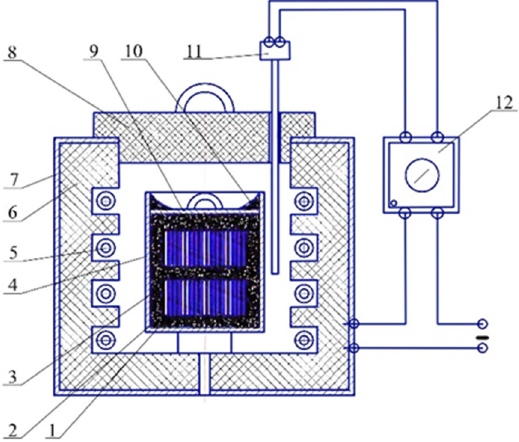
Figure 1. The design scheme of the stand for nitrocarburizing of valve plates: 1—plate; 2—carbon- nitrogen coating; 3—filler (sand with carbon black); 4—container; 5—electric heater; 6—furnace lin- ing; 7—furnace housing; 8—furnace lid; 9—container lid; 10—sand-clay seal; 11—thermocouple; 12—temperature controller.